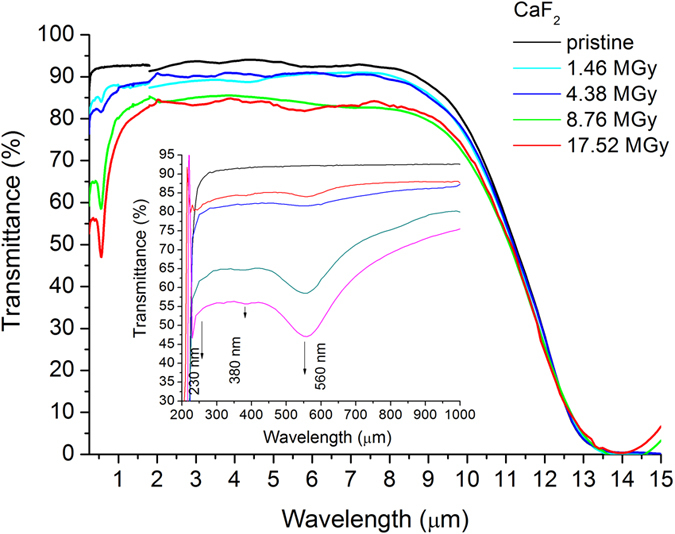
Spectral optical transmittance before and after alpha irradiation of CaF2.